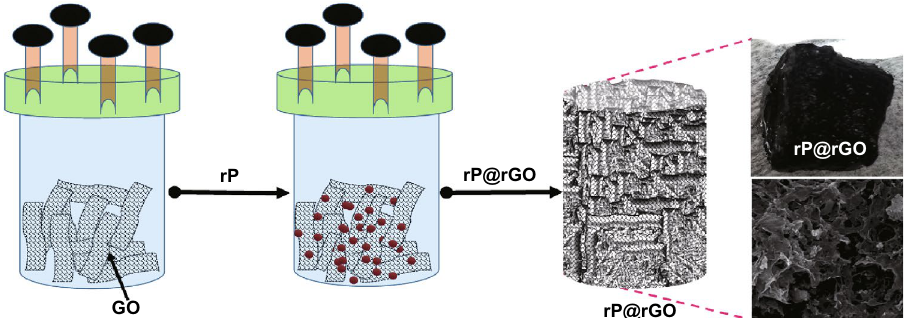
Fig. 1 Steps involved in the synthesis of the rP@rGO